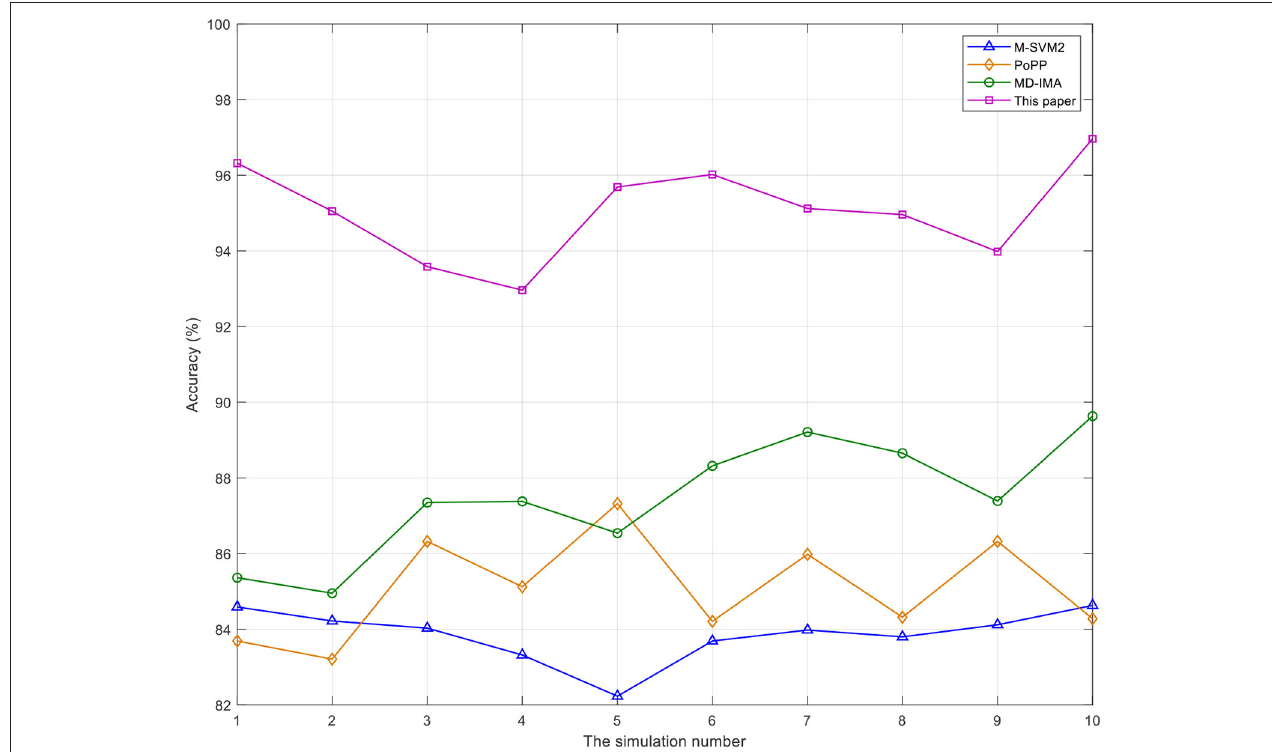
FIGURE 2 | The comparison of the accuracy of mental state recognition of undergraduates in medical college by different methods.